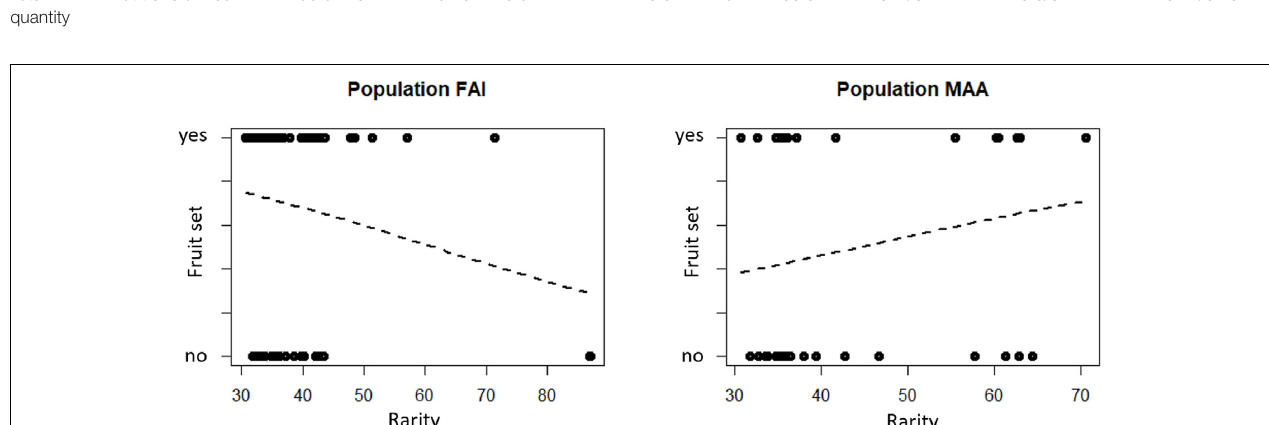
Frontiers in Plant Science |